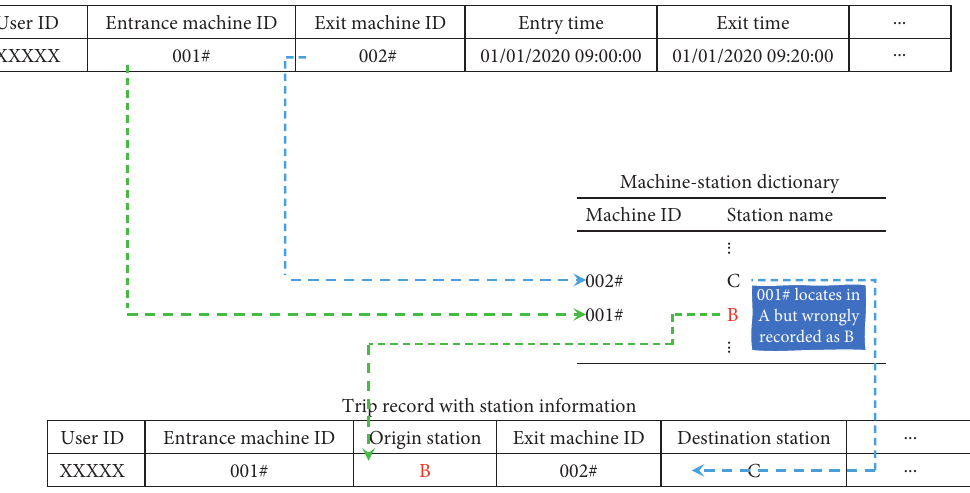
Figure 2: Invalid association problem between fare machine and metro